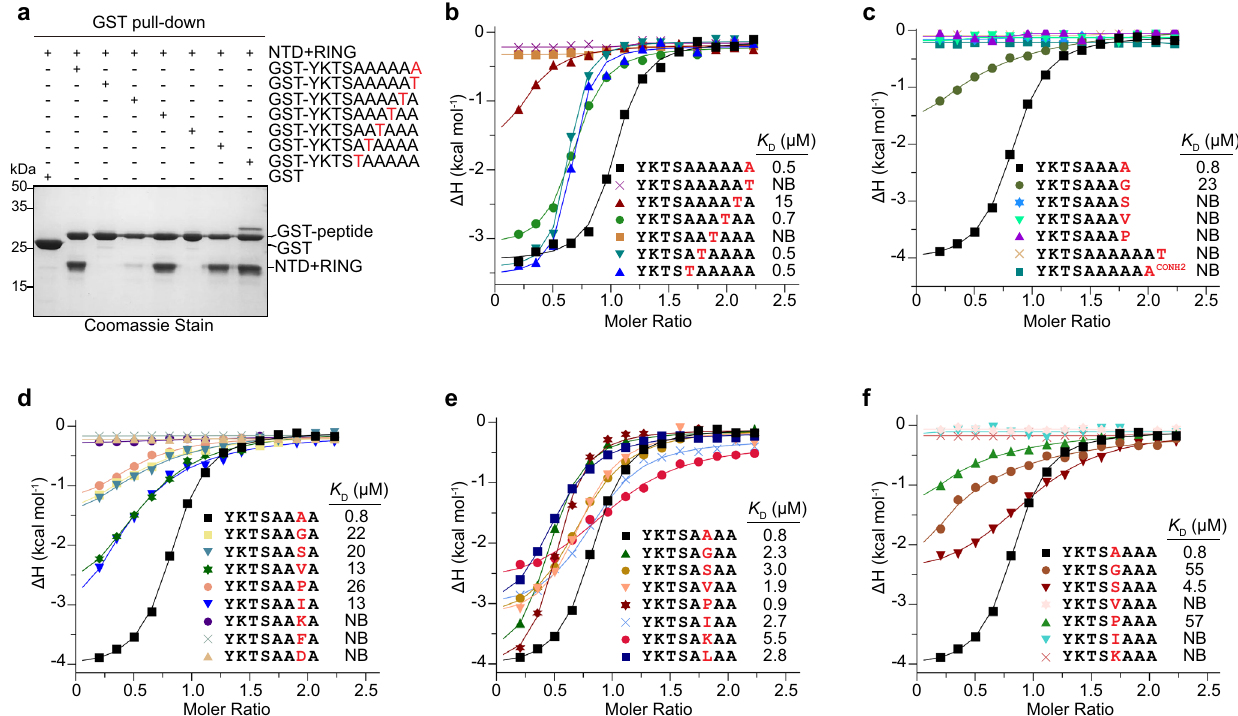
Fig. 5 | Substrate speci fi city of Pirh2-mediated Ala6/C-degron recognition. a GSTpull-down assay using GST-fused Ala6/C-degron or its mutants to pull down Pirh2 (NTD+RING). Representative images, n =3. Source data are provided as a Source Data fi le. b – f ITC fi tting curves of Pirh2 (NTD+RING) titrated by a series of